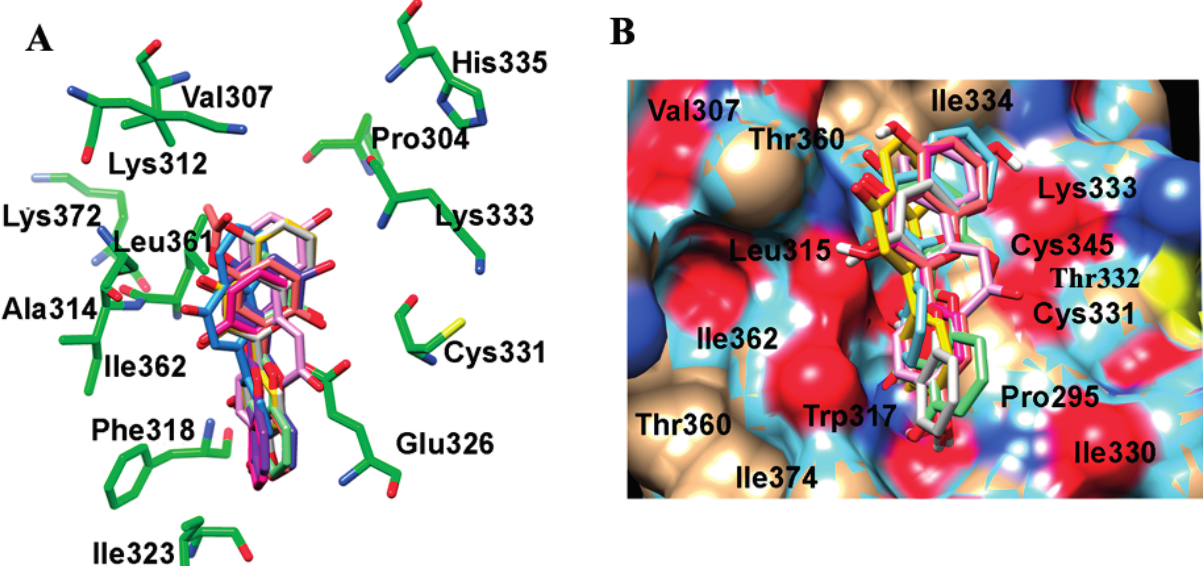
Figure 2. Molecular modelling showing interaction of 7,8-DHF derivatives with the TrkB. ( A ) Amino acid interactions of TrkB (green) with the stick model of 7,8-DHF derivatives (red, blue, yellow, cyan, pink and orange); ( B ) Space filled surface view model of TrkB (color by heteroatom) to depict the binding pocket of 7,8-DHF derivatives (stick model) in TrkB domain.